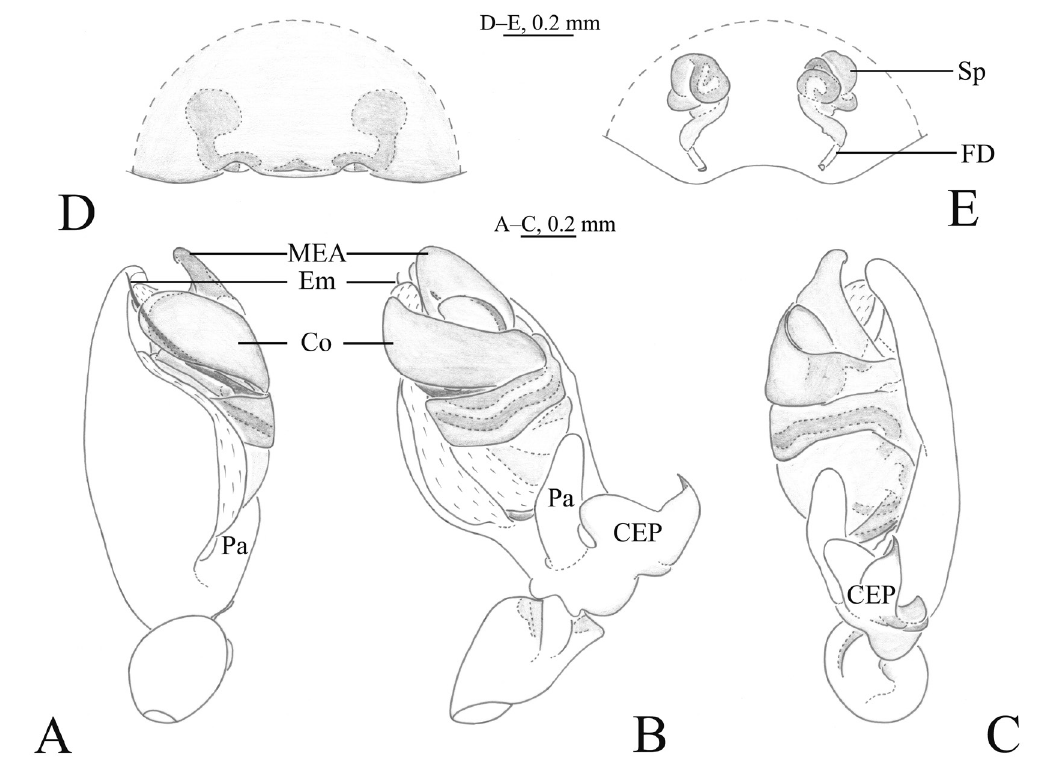
Fig. 19. Meta weining sp. nov. A–C . ♂, holotype (SWUC-T-TEg-08-01). D–E . ♀, paratype (SWUC-T- TEg-08-03). A . Left palp, prolateral view. B . Same, ventral view. C . Same, retrolateral view. D . Epigyne, ventral view. E . Vulva, dorsal